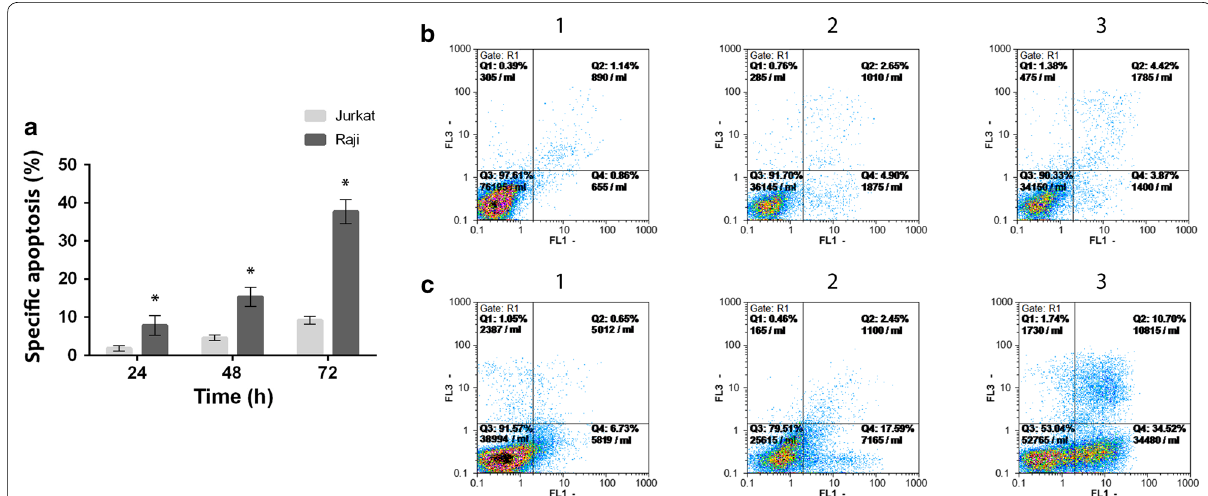
Fig. 7 Apoptosis induced by scFv–apoptin in Raji and Jurkat cells assayed by Annexin-V/PI staining. a Percentage of specific apoptosis in Raji and Jurkat cells incubated with recombinant scFv–apoptin. 24, 48 and 72 h later, Annexin-V/PI staining was quantified by flow cytometric analysis. The rate of specific apoptosis in the Raji cells was significantly higher than that of Jurkat cells. Data represents mean independently performed experiments (* p < 0.05 ). Flow cytometric graphs of un-treated ( b ) and scFv–apoptin treated ( c ) Raji cells incubated for 24 (1), 48 (2) and 72 (3) h. early apoptotic cells are Annexin-V-positive, PI-negative ( lower right ), whereas late apoptotic cells are Annexin-V positive and PI-positive ( upper right